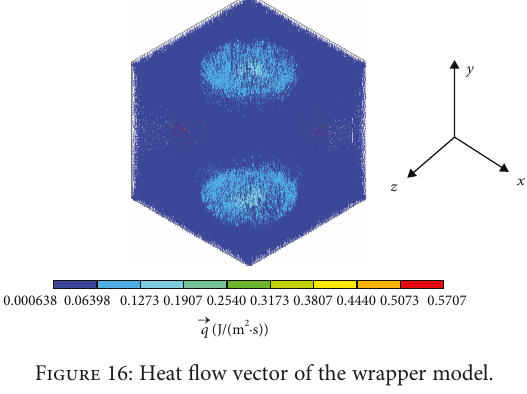
Figure 16: Heat fl ow vector of the wrapper model.